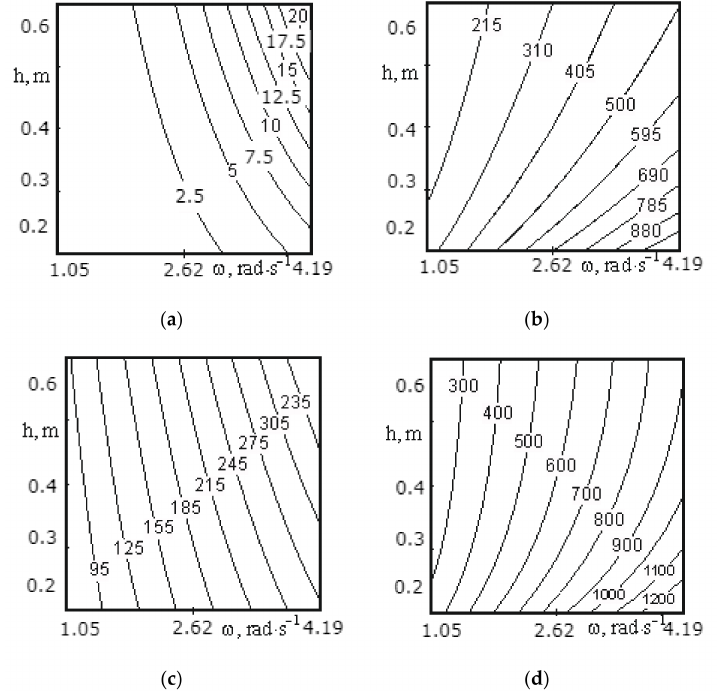
Figure 12. Dependence of the power value on the speed of mixer shaft rotation and the pitch of a screw tape turn for the middle screw: ( a ) the surface constructed based on calculations on the first component; ( b ) the surface constructed based on calculations on the second component; ( c ) the surface constructed based on calculations on the third component; ( d ) the surface representing the change in the total power value for all three